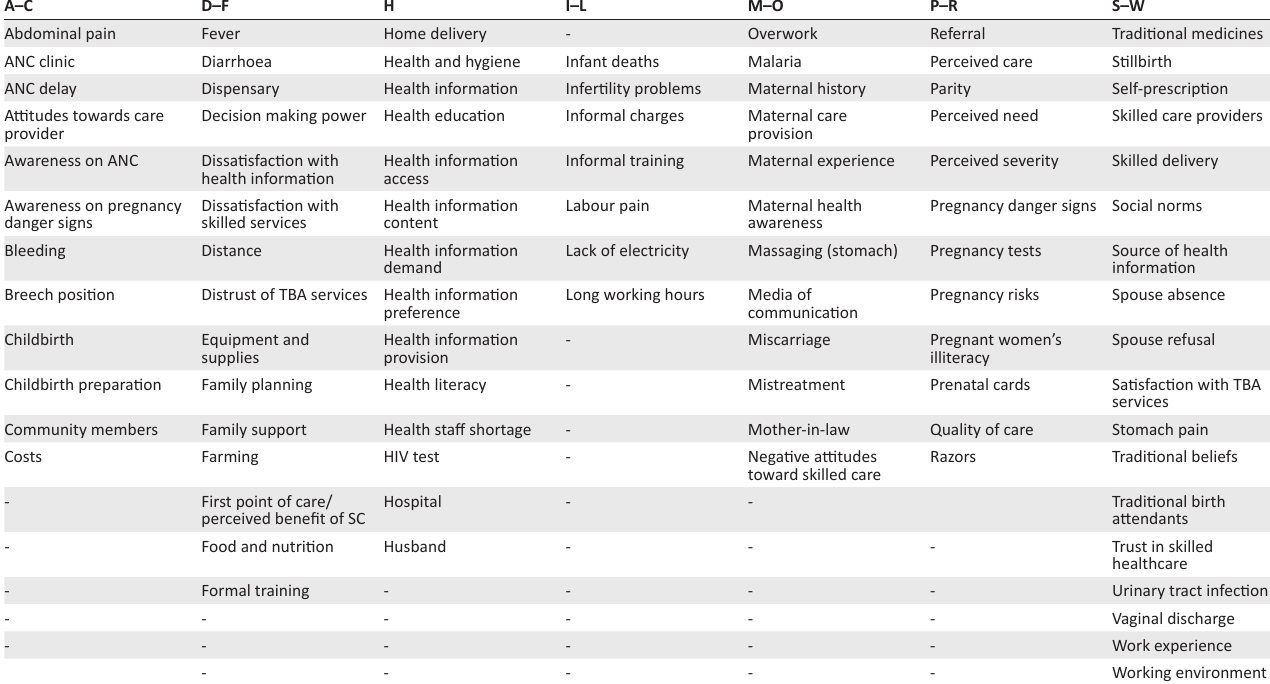
TABLE 1: List of final